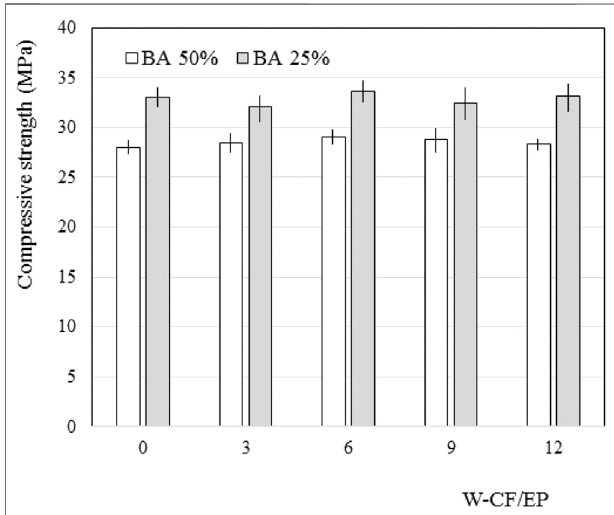
FIGURE 8 | Compressive strength of the investigated materials vs amount of recycled composite.